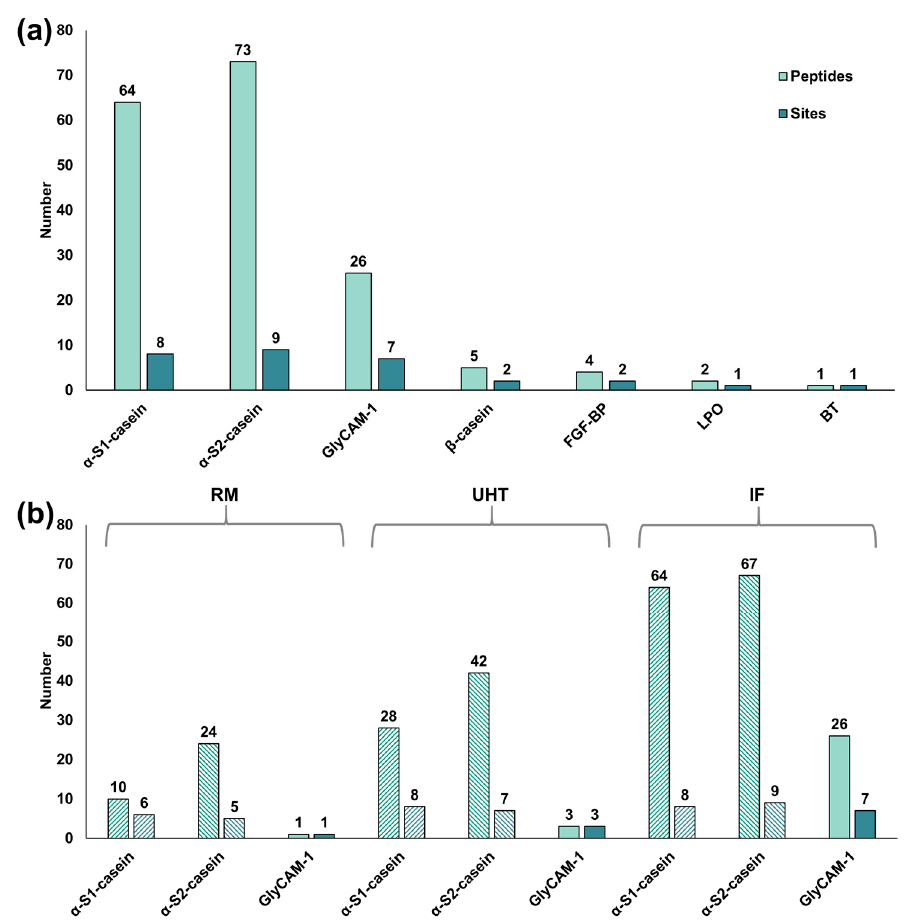
Figure 4. ( a ) Number of peptides and modification sites identified per modified protein in all milk samples; ( b ) Number of peptides (first bar) and modification sites (second bar) identified per protein in RM, UHT milk, and IF. Abbreviations: FGF-BP—fibroblast growth factor-binding protein 1, LPO—lactoperoxidase, and BT—butyrophilin subfamily 1 member A1.